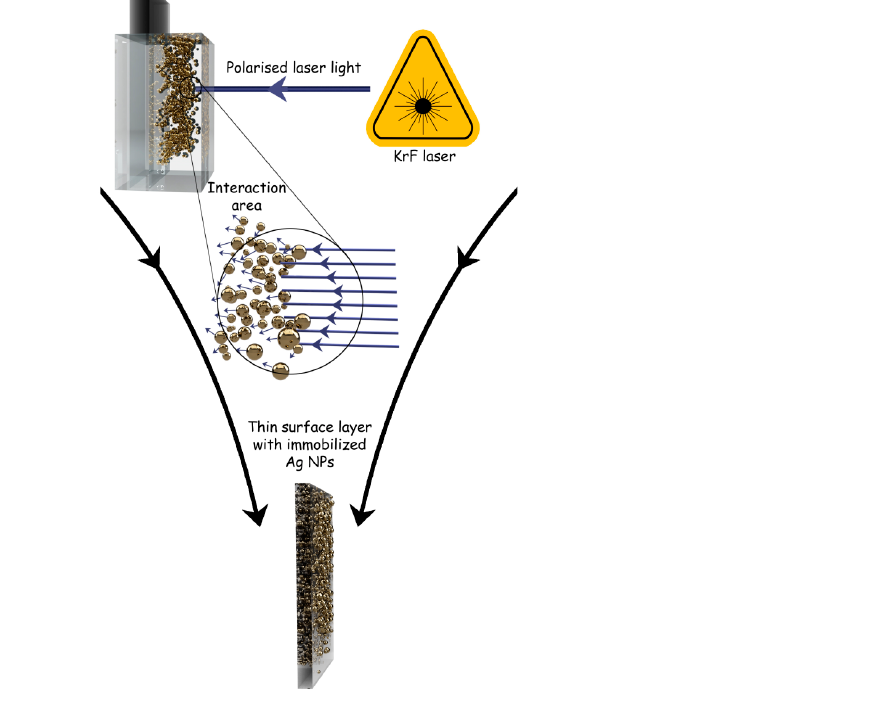
Figure 18. Scheme of the process of immobilization of silver nanoparticles (AgNPs) on polymers by the action of laser beam, resulting in a thin surface layer of polymer enriched with AgNPs.